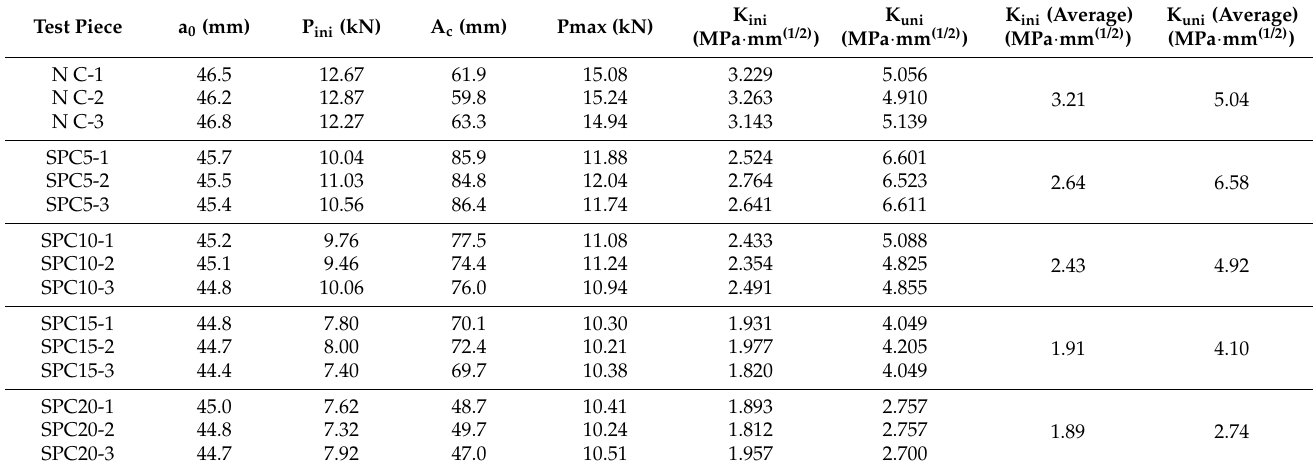
Figure 9. Double-K fracture parameters of concrete with different steel-slag-powder replacement ratios. Table 5. The calculated results of double-K fracture parameters of SFC.